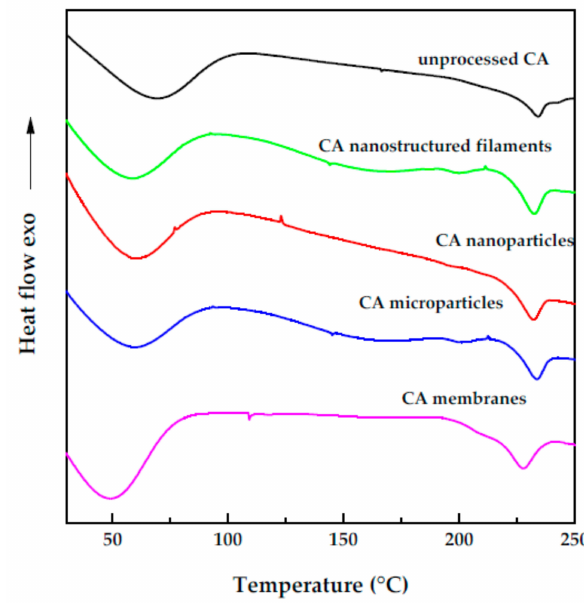
Figure 7. DSC thermograms for unprocessed CA, SAS processed CA and CA membranes; exo indicates exothermic